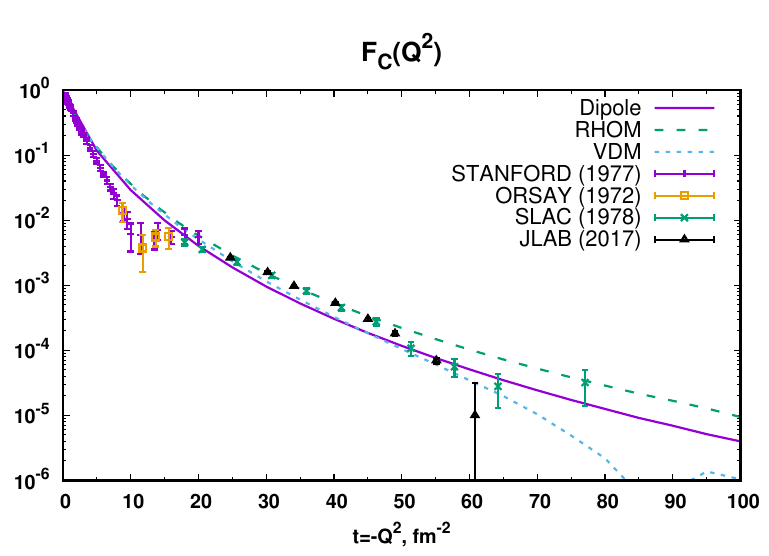
Figure 1. (Color online) The charge form factor of 3 He. Solid line is the result of using the Dipole fit, long dashed line – with RHOM, and short dashed line with VDM. The experimental data STAN- FORD (1977) are from [17], ORSAY (1972) – [18], SLAC (1978) – [19], JLAB (2017) –